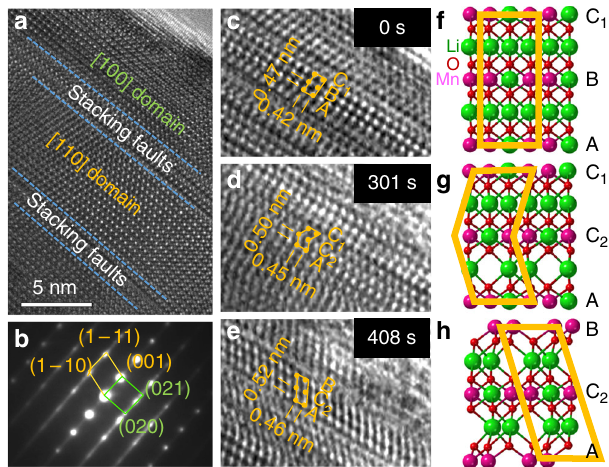
Fig. 1 The exitance form and motion of stacking faults in lithium extraction process. a Transmission electron microscopy (TEM) image of (001) stacking faults in pristine Li 2 MnO 3 with fault vector of b /6[110], which are con fi rmed by a corresponding electron diffraction ( b ). During delithiation, the gliding of the b /6[110] partial dislocation shears the stacking of the (001) plane from ABC 1 in pristine Li 2 MnO 3 ( c ), to AC 2 C 1 ( d ), and AC 2 B ( e ) after 0, 301, and 408 s, respectively; corresponding density functional theory (DFT) structural models are provided of pristine Li 2 MnO 3 ( f ) and generated defects ( g , h ), respectively. The scale bar is 5